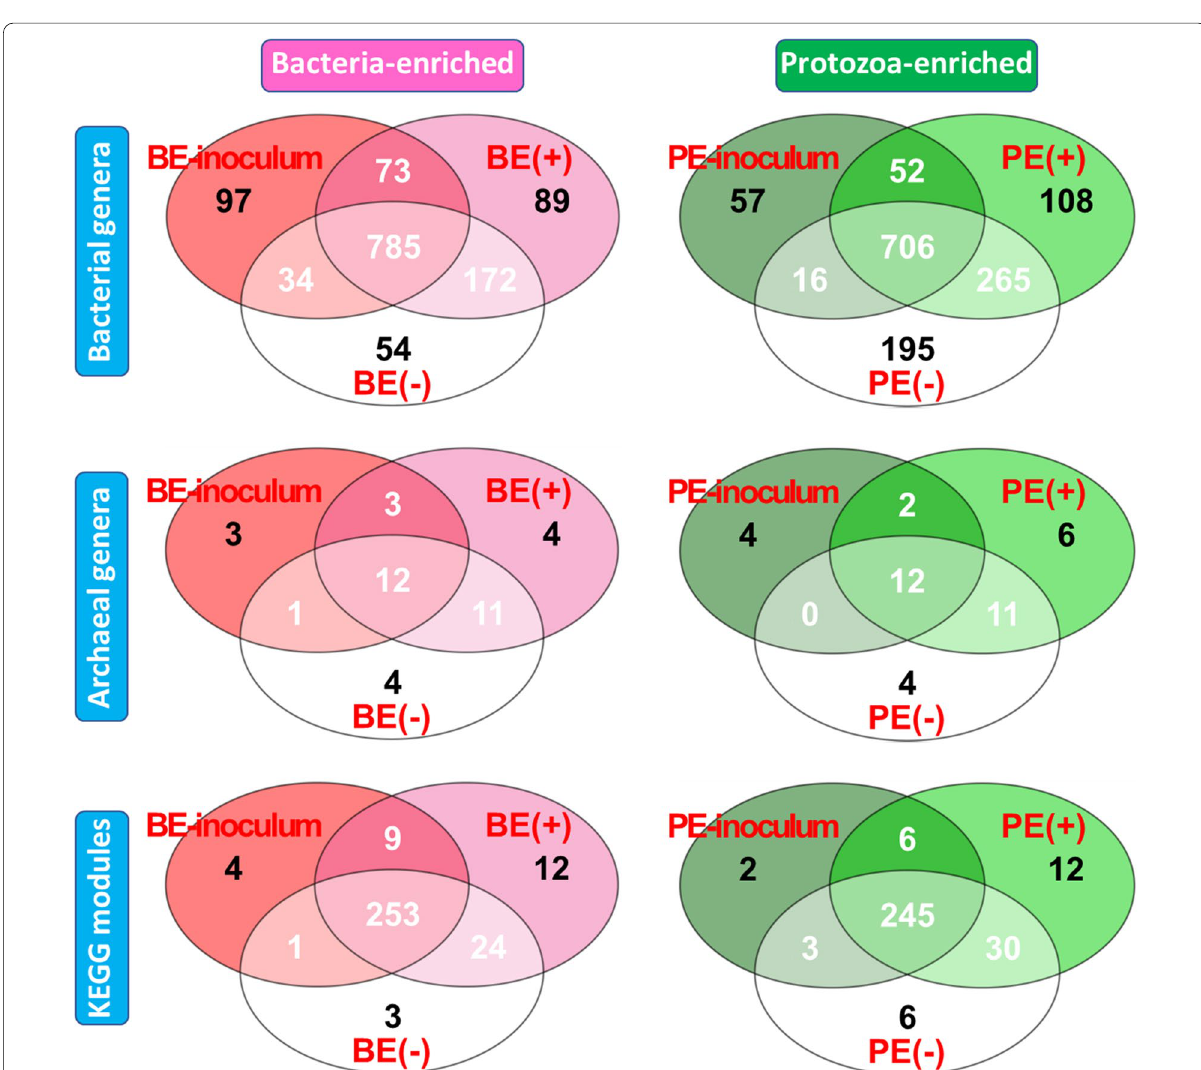
Fig. 5 Number of bacterial, archaeal genera and KEGG modules which were differentially observed by microbial inoculations. The number of shared or exclusively found genera or functional features among the corresponded microbial inocula, inocula-treated and controls were shown in Venn diagram. BE, bacterial-enriched rumen fluid; PE, protozoal-enriched rumen